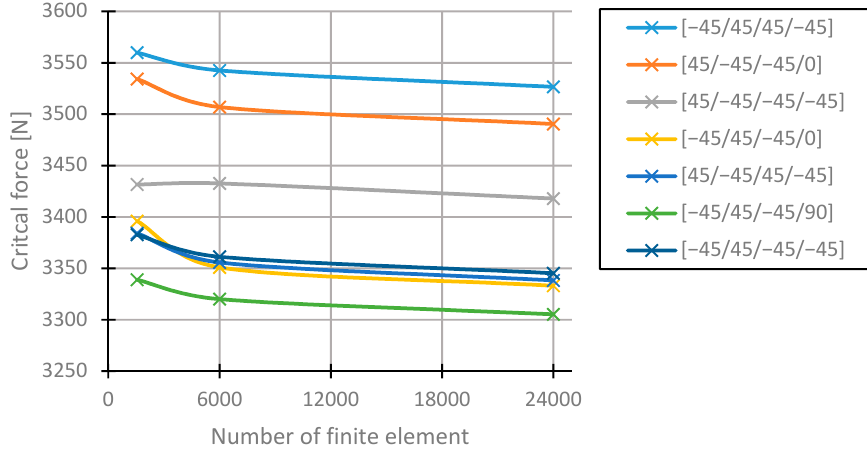
Figure 6. Values of the critical forces for different layer arrangements for different levels of finite element methods (FEM) mesh densification.